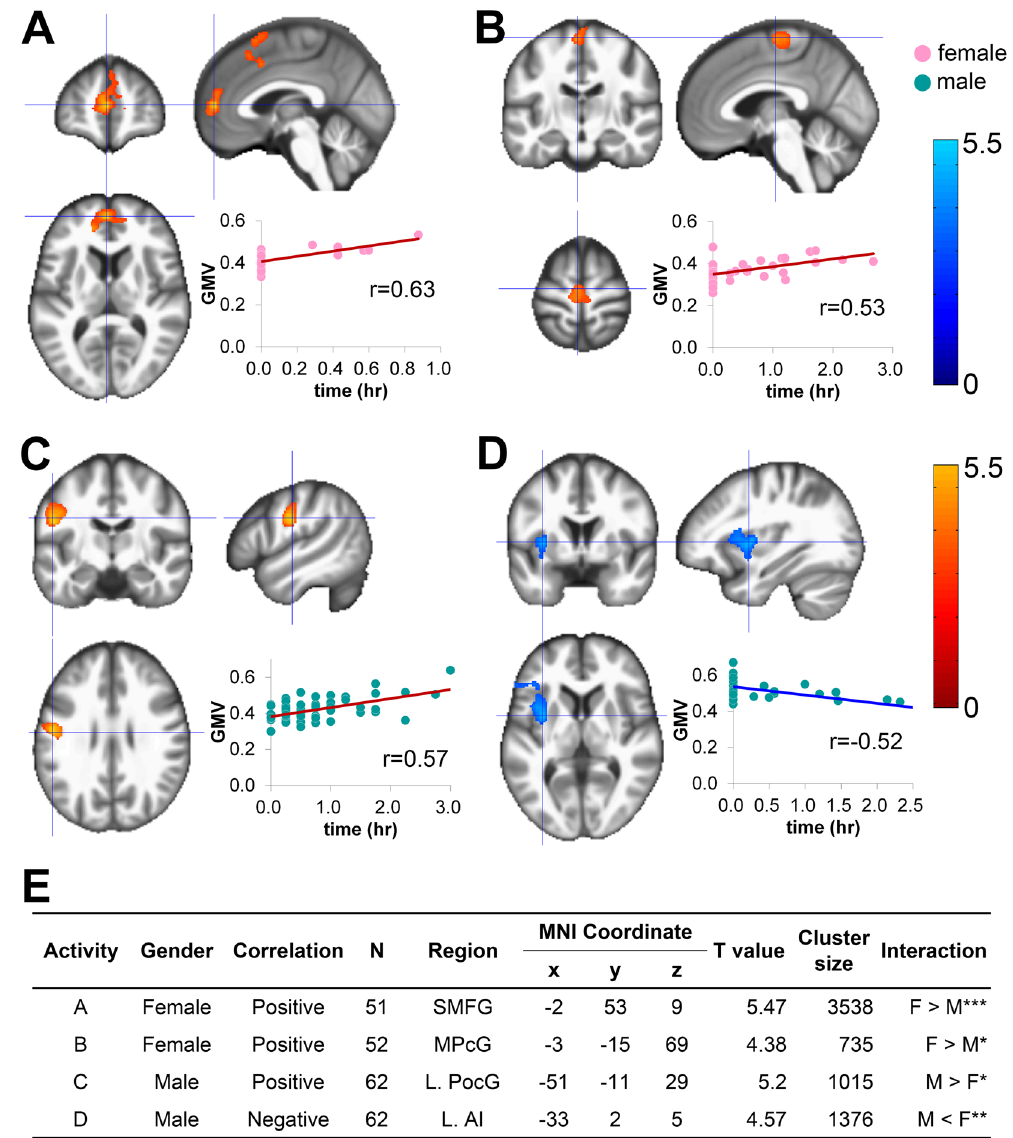
Figure 2. Sex-specific correlations between GMV and each secondary activity item. Regions that survived a statistical threshold of p < 0.05 (cluster-level corrected for multiple comparisons) are shown with ( A ) daily time of Learning/self-development in females, ( B ) daily time of Hobbies/amusements in females, ( C ) weekly range of daily time of Personal care in males, and ( D ) daily time of Other social activities in males. ( E ) Summary of the significant correlations. The X-axis of the scatter plot indicates the daily time or weekly range of activities. The Y-axis indicates the extracted GMV over the peak coordinates of the significant cluster. L, left; MNI,